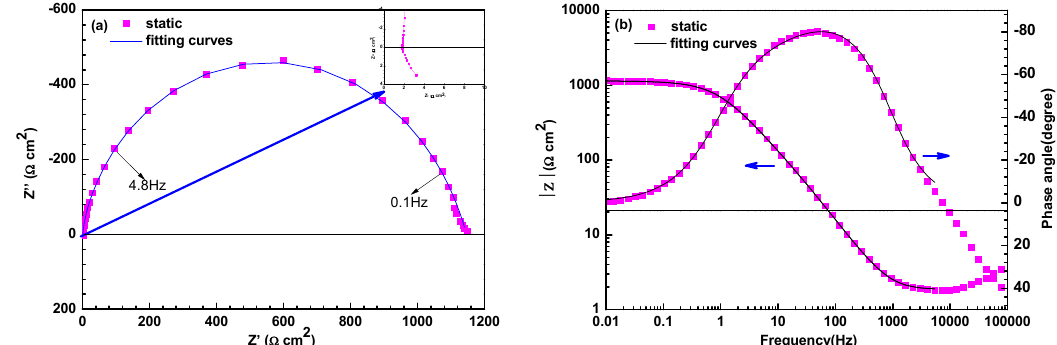
Figure 4. Nyquist plots under FAC and E-C conditions.